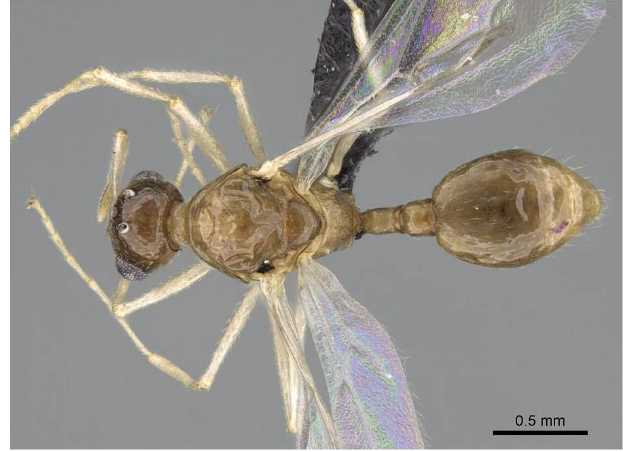
Fig 12 . Temnothorax ansei sp.n. male in dorsal view. Photo credit: Michele Esposito, from www.AntWeb.org,CASENT0919954_D, published with permission.